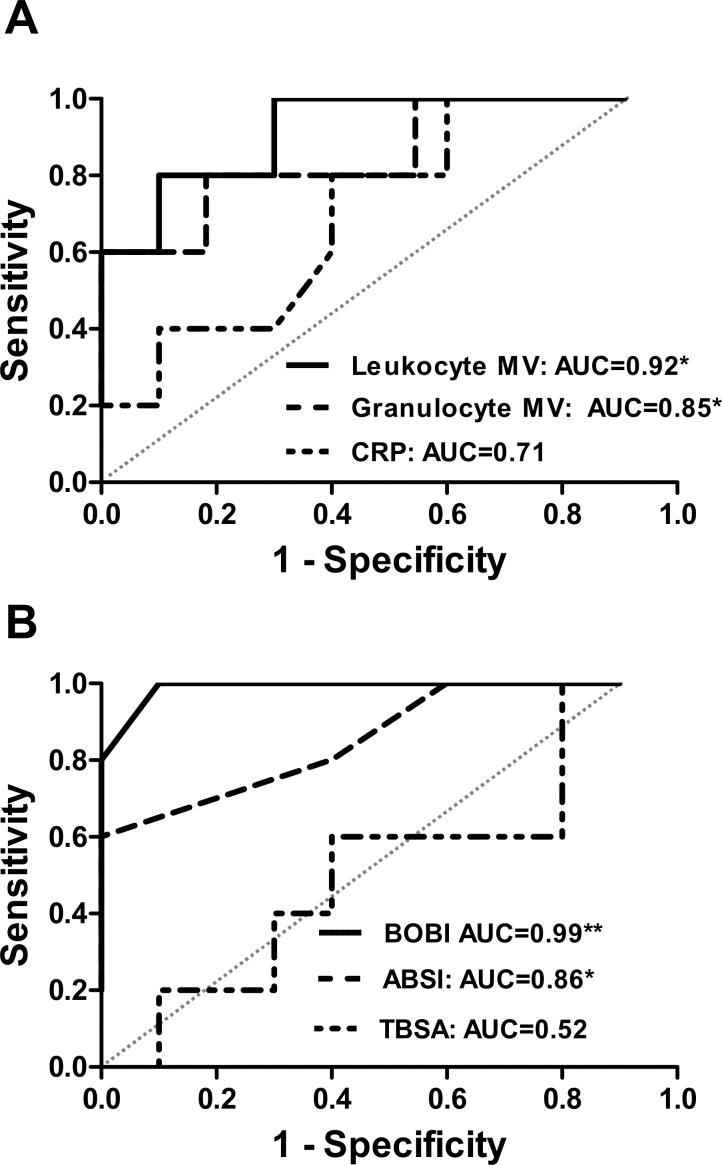
Receiver operator characteristic curves for circulating leukocyte MVs in burns patients.Receiver operating characteristic (ROC) curves and corresponding area under the curve values for: leukocyte-derived MVs, neutrophil-derived MVs and CRP (A), and for BOBI, ABSI and TBSA (B). *p < 0.05, **p < 0.01.